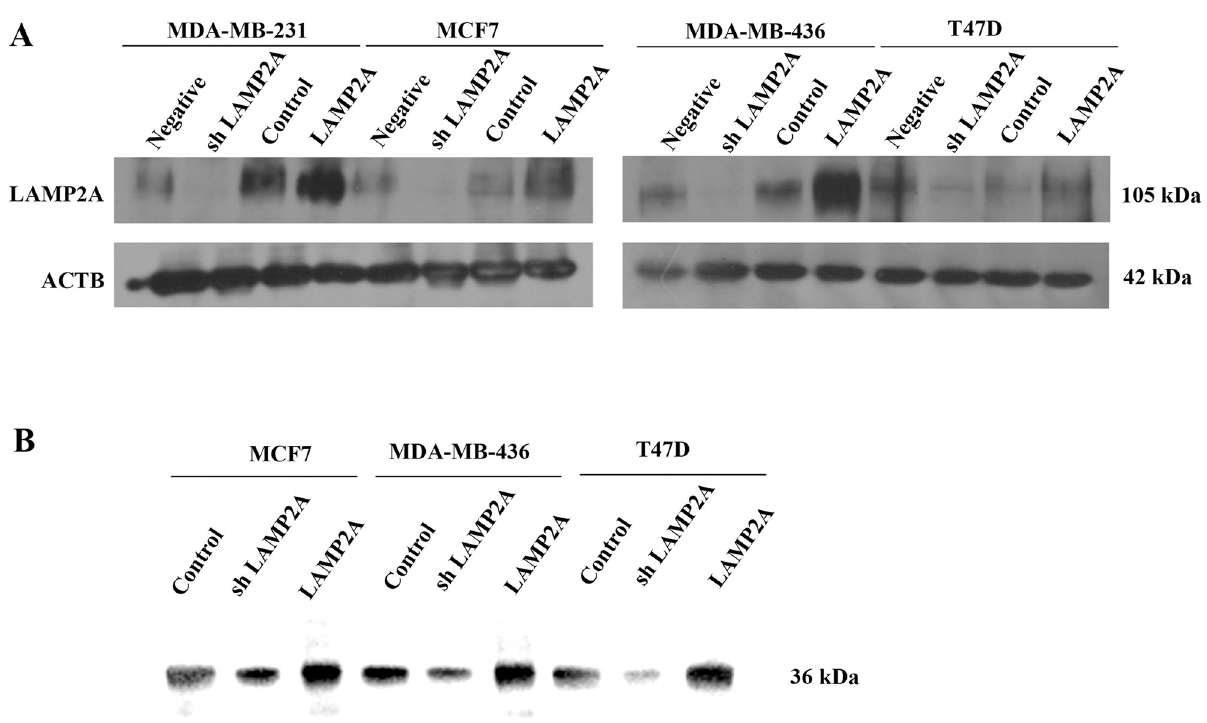
Fig 1. Establishment of breast cancer cell lines with different CMA activity. (A) Immunoblotting was used to detect the stable efficiency of lentivirus mediated inhibitory shRNAs or overexpression against LAMP2A in MDA-MB-231, MCF7, MDA-MB-436 and T47D cells. (B) Intact lysosomes from breast cancer cells with different LAMP2A expression was incubated with purified recombinant protein of GAPDH, and then collected, fractionated and immunoblotted with GAPDH antibody to detect CMA activity.